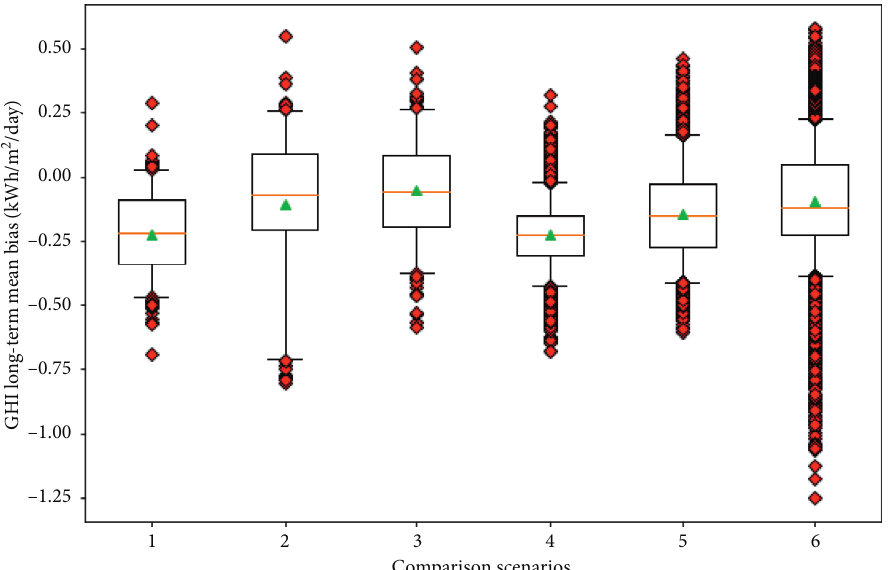
Figure 4: GHI mean bias between two databases. ( 1 ) POWER vs SolarGIS. ( 2 ) POWER vs SARAH-E. ( 3 ) POWER vs CLARA-A2. ( 4 ) CLARA-A2 vs SolarGIS. ( 5 ) CLARA-A2 vs SARAH-E. ( 6 ) SARAH-E vs SolarGIS. Orange line, median and green triangle,